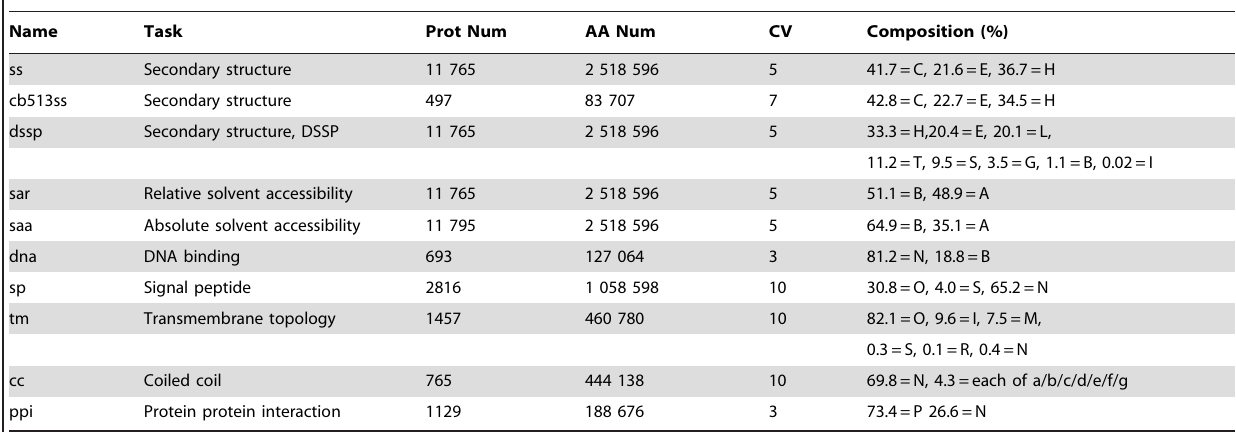
Table 1. Summary of data sets.